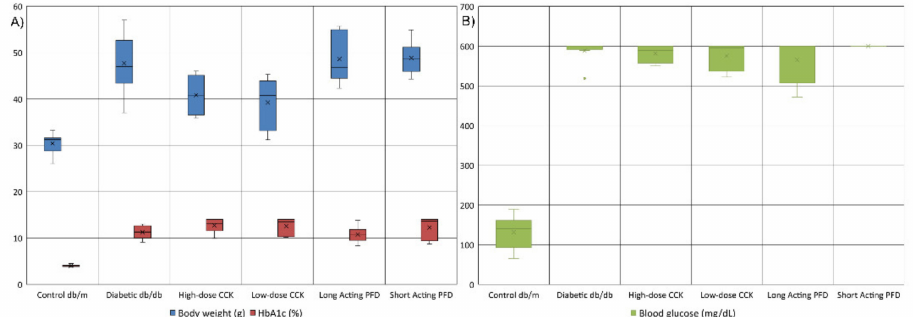
Figure 1. ( A ) The distribution of the HbA1c (%age) and body weight (g) of the control db / m ( n = 7) and diabetic db / db ( n = 6) mice as well as four treatment groups of diabetic db / db ( n = 6 each group) ( B ) The distribution of glucose (mg / L) in various mice groups. High level of HbA1c correlated with chronic kidney disease (CKD). The x marker in the box plot represents the average